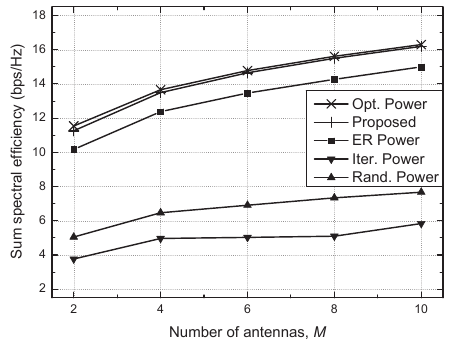
Figure 5. Sum spectral efficiency vs. number of antennas ( M